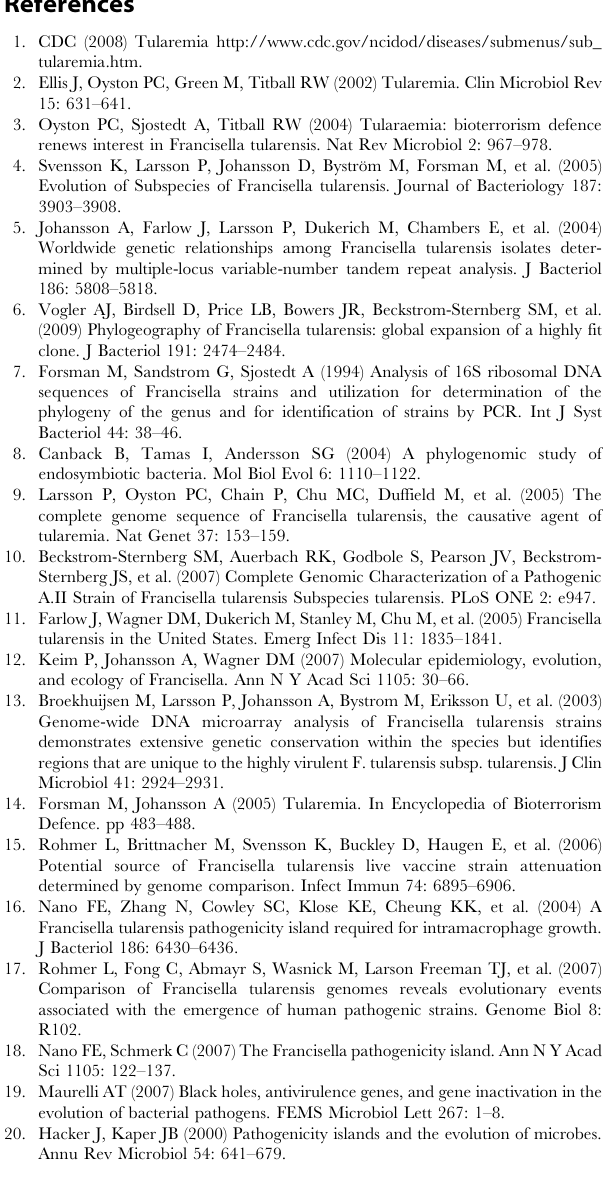
(X axis) in all dotplot comparisons (A–C). (A) F. tularensis subsp. mediasiatica FSC147 and F. tularensis subsp. novicida GA99-3548, (B) F. tularensis subsp. mediasiatica FSC147 and F. tularensis subsp. holarctica FSC022, (C) F. tularensis subsp. mediasiatica FSC147 and F. tularensis subsp. tularensis SCHU S4. Alignments were filtered for overlap percentages greater than or equal to 90%. Numerous rearrange- ments are evident from the dotplot comparisons. Table S1 Subspecies specific disruption of genes encoding proteins of major secretory pathways, membrane proteins and components of known metabolic pathways.